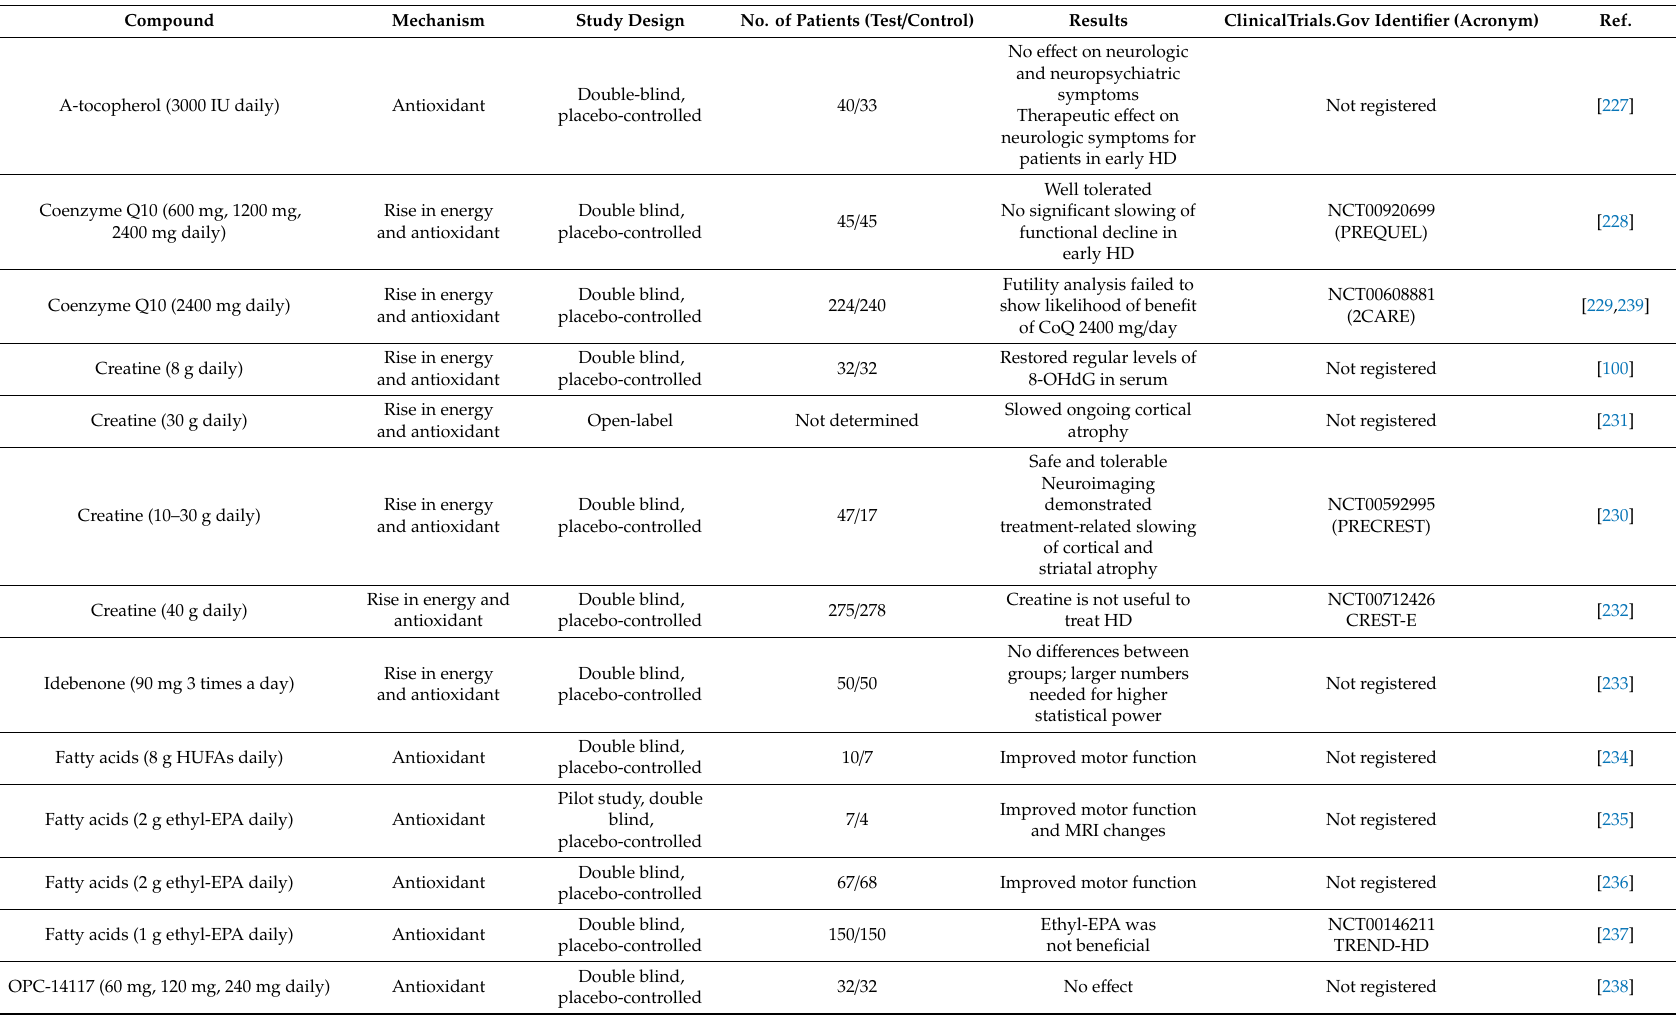
Table 4. Clinical assays using antioxidants for therapeutic intervention in